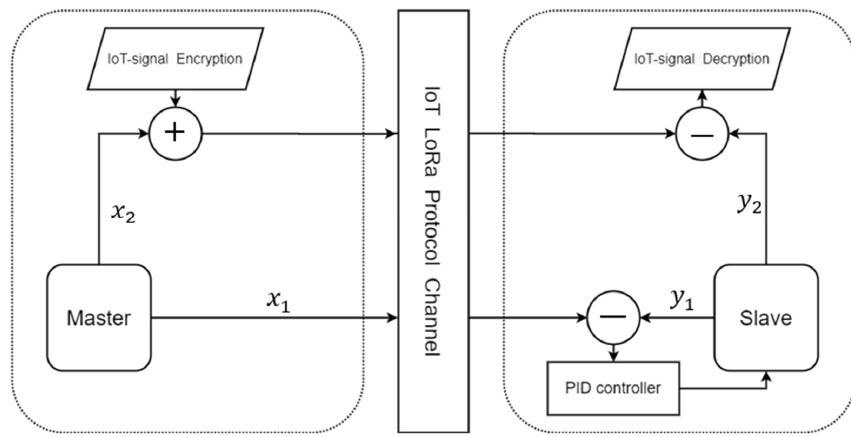
Figure 8. The secure IoT signal system architecture (PID).